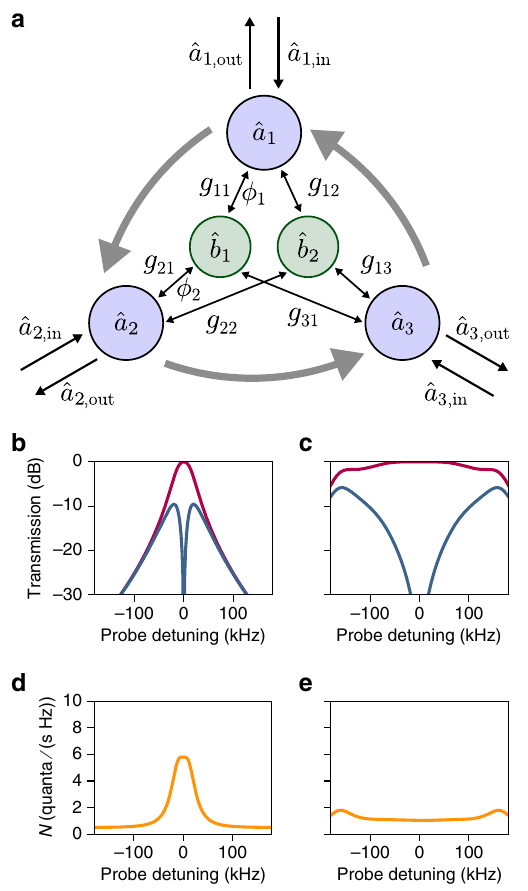
Fig. 5 Proposal for a microwave optomechanical circulator. a With a third microwave mode ^ a 3 coupled to the same two mechanical oscillators, circulation can be achieved between the three microwave cavities. The circuit now involves two independent loops, with two phases ϕ 1 and ϕ 2 that can be tuned with the phases associated with g 21 and g 11 , respectively. b , c The theoretical transmission in the circulating direction (counter- clockwise, in red ) and the opposite direction (clockwise, in blue ) are shown for the cooperativities C ¼ 100 ( b ) and C ¼ 1000 ( c ). The isolation bandwidth scales with C and is only limited by the energy decay rates of the microwave modes. Experimentally realistic parameters are chosen with overcoupled cavities of energy decay rates κ 1 = κ 2 = κ 3 = 2 π ⋅ 200 kHz and Γ = Γ = 2 π ⋅ 100 Hz. d , e Noise emission spectra for the same two m,1 m,2 cooperativities ( C ¼ 100 ( d ) and C ¼ 1000 ( e )), for n m ; 1 ¼ n m ; 2 ¼ 800. Note that for the circulator the noise is symmetric for all the cavities, and that it decreases with increasing